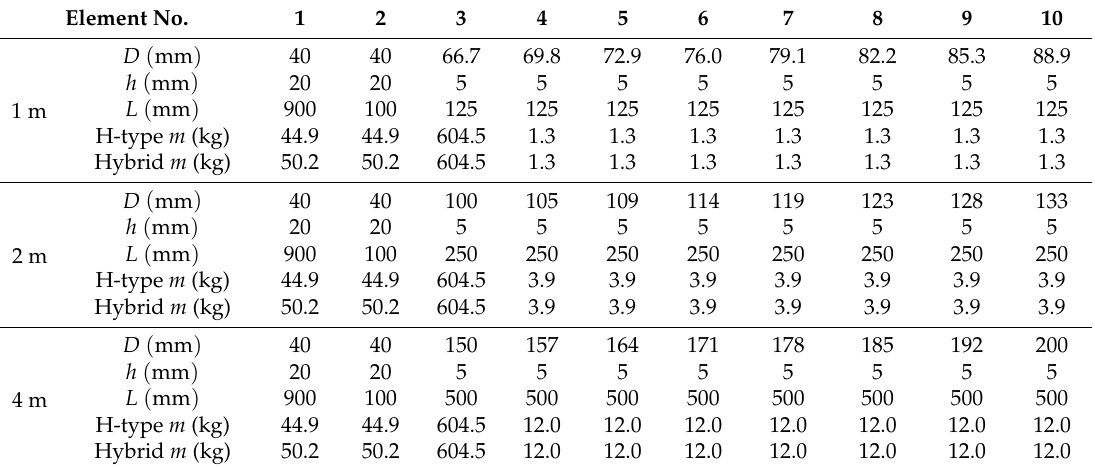
Table 5. Geometric properties of the MDOF model of the H-type and hybrid VAWTs. Element No.